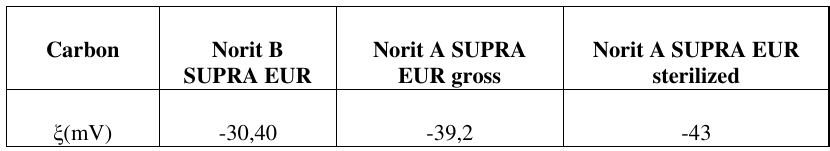
Table 2. Zeta potential in water of activated